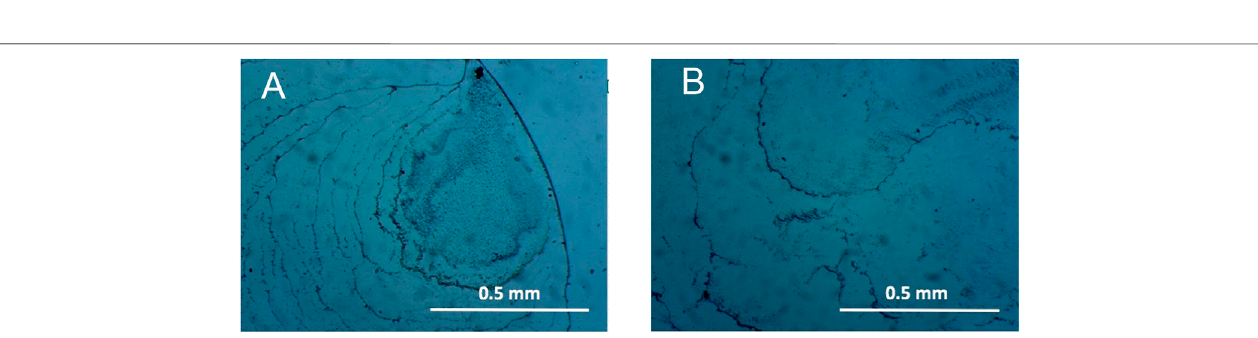
FIGURE 8 | Examples of photos of the accumulation of microspheres in dried droplets in 1 × 10 – 7 M HyFn (left, (A) and water potency 1 × 10 – 7 M (right, (B) .